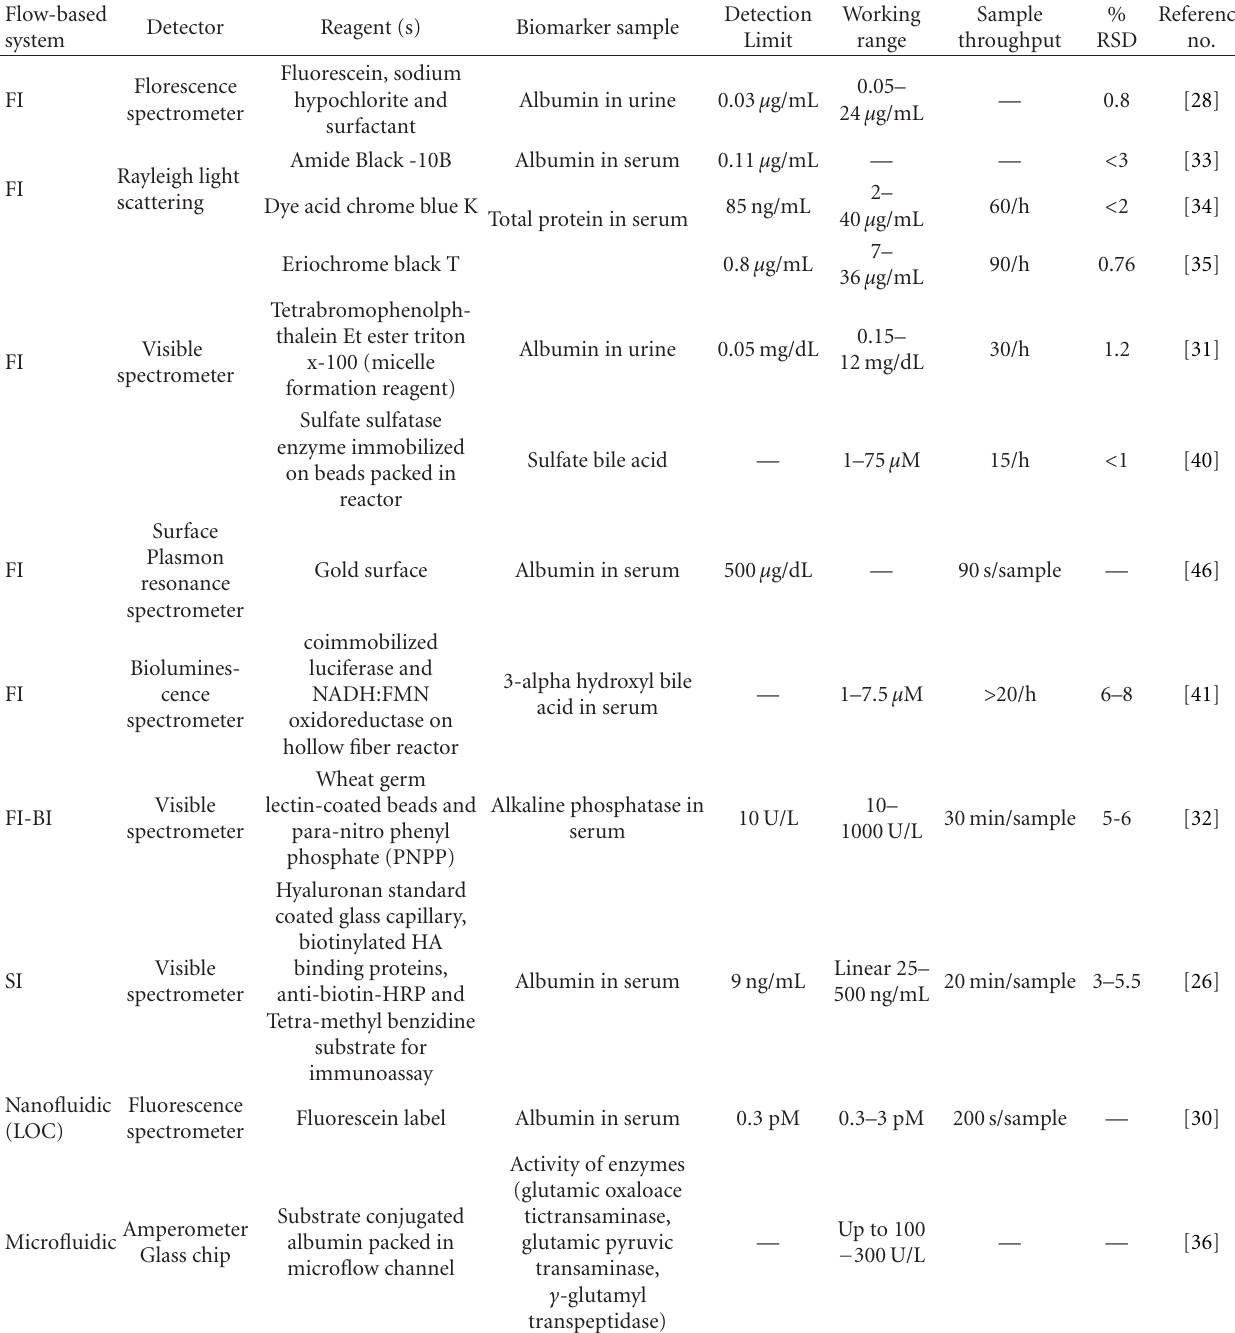
Table 1: Summarization of works reported on liver diseases biomarkers using flow-based analysis systems. FI: flow injection; FI-BI: flow injection-bead injection; SI: sequential injection; LOC: lab on